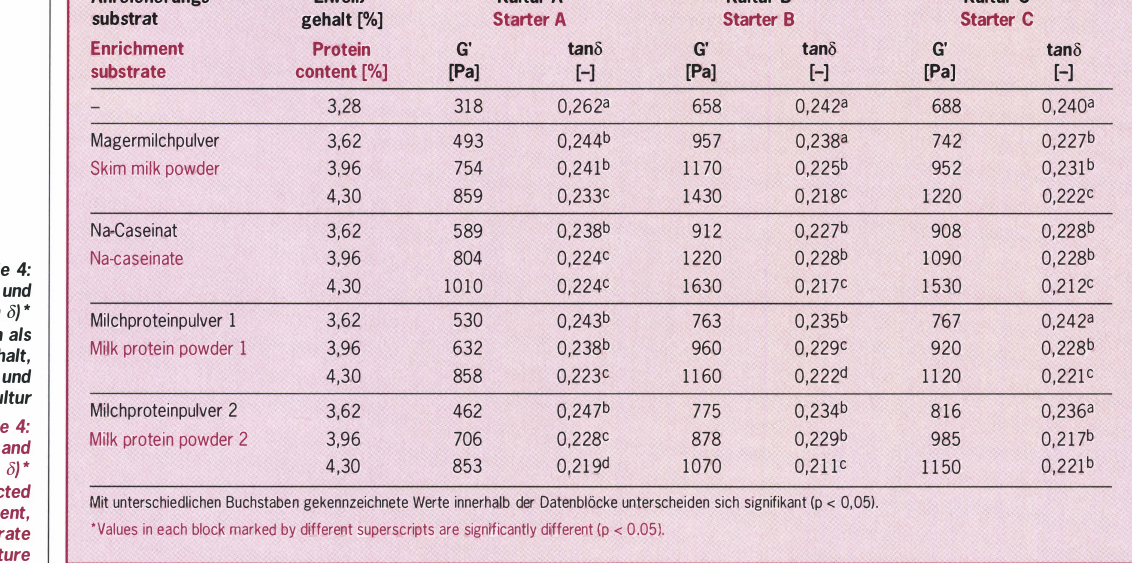
Tabel/e 4: Speichermodul (G') und Phasenverschiebung (tan 8) • von Joghurtgelen als Funktion von Eiwei/Jgehalt, Anreicherungssubstrat und Fermentationskultur Table 4: Milk protein powder 2 Storage modulus (G') and phase shift (tan 8) • of yogurt gels as affected Mit unterschiedlichen Buchstaben gekennzeichnete Werte innerhalb der Datenblocke unterscheiden sich signifikant (p < by protein content, 'Values in each block marked by different superscripts are significantly different (p < enrichment substrate and starter culture exponentiellen Zusammenhangs zwischen den dynami­ schen Moduln und dem Caseingehalt vor [10]. Unabhangig vom Kulturtyp zeigte die Regression von G' auf den EiweiBgehalt signifikante Korrelationskoeffi­ zienten (p 0,001). Weitere Regressionsanalysen wur­ < den mit dem Caseingehalt-ermittelt aus Daten in Tabelle 1 -anstelle des EiweiBgehalts als unabhangi­ ger Variable berechnet. Diese Madelle wiesen deutlich niedrigere Abweichungsquadratsummen auf, dadurch erhbhten sich die einzelnen Korrelationskoeffizienten auf etwa 0,95. Die Datenpaare und Ausgleichsgeraden fUr Joghurt A und C sind in Abb. 3 dargestellt, die Regressionsfunktion fUr Joghurt B war ahnlich wie fUr nent = 2,5 ist mit Literaturwerten [10] vergleichbar.